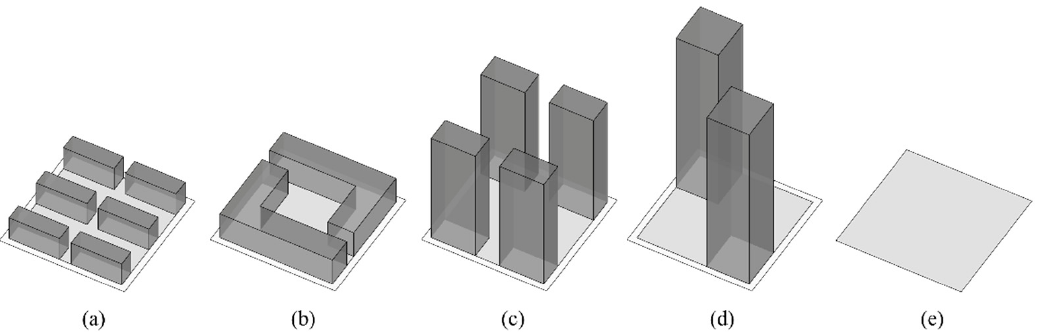
Figure 3. Basic building form extracted from urban block: ( a ) strip type building form; ( b ). courtyard type building form; ( c ). high-rise strip type building form; ( d ). high-rise dot type building form; ( e ). open space. Table 1. Building height and form selected from Taiyuan Block.